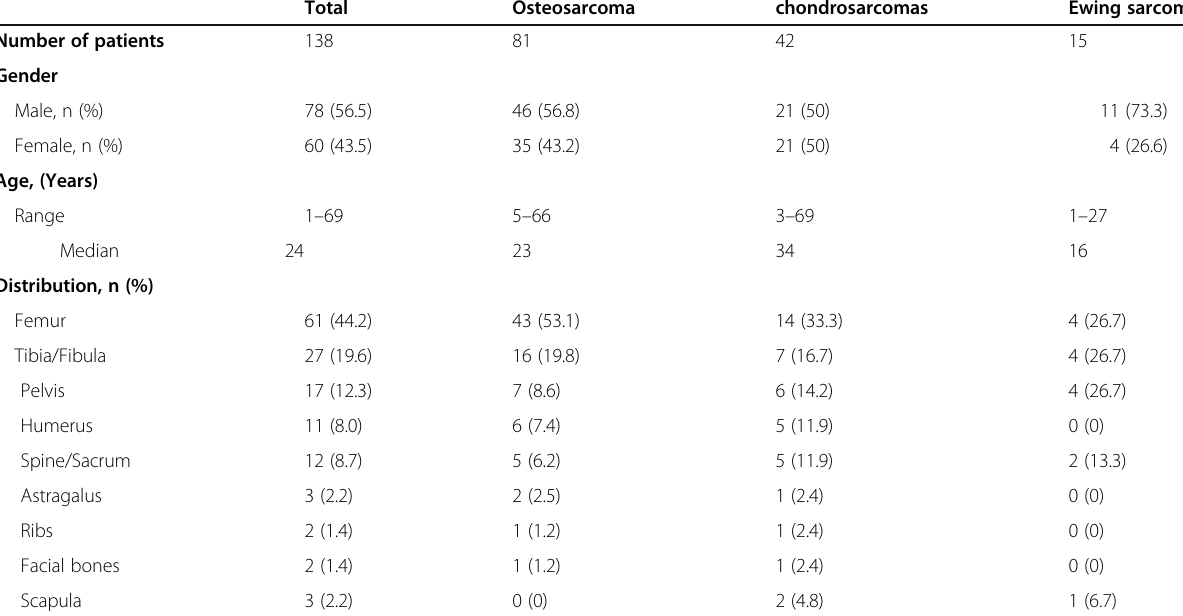
Table 1 Clinicopathological features of osteosarcoma, chondrosarcomas and Ewing sarcoma Total Osteosarcoma chondrosarcomas Ewing